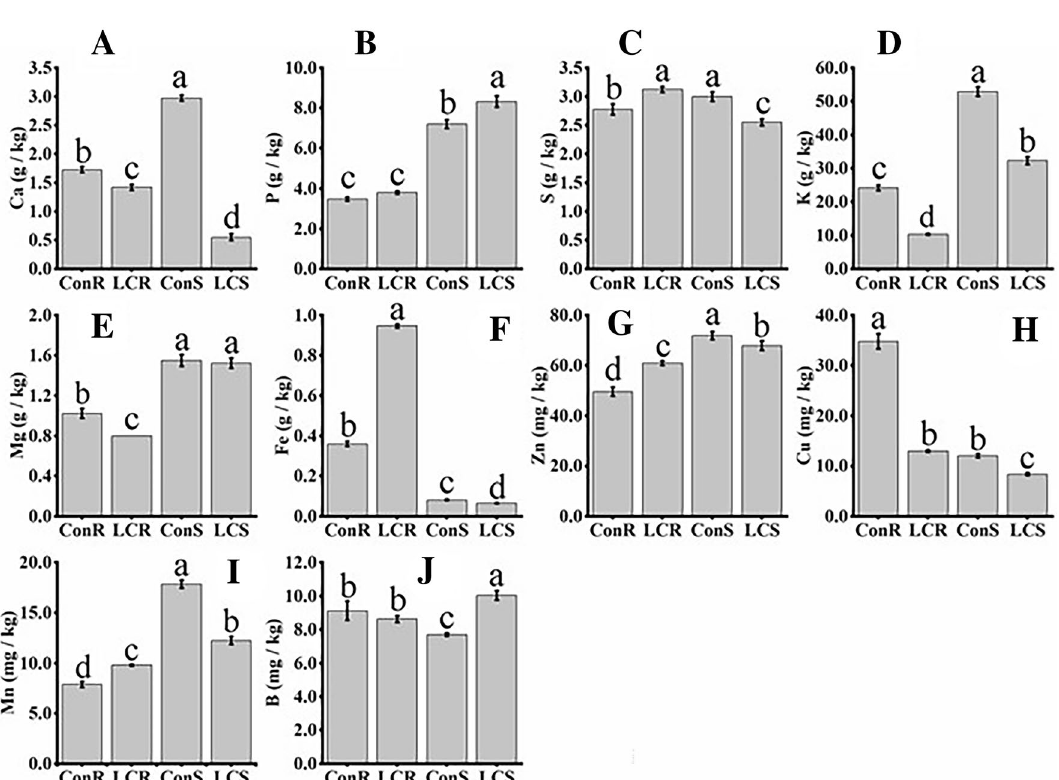
Figure 2. Mineral content profiling of tef plants grown under low or optimum Ca conditions. Shoot and root Ca ( A ), P ( B ), S ( C ), K ( D ), Mg ( E ), Fe ( F ), Zn ( G ), Cu ( H ), Mn ( I ) and B ( J ) were analyzed using ICP-OES as described in the “Materials and methods” section. Bars represent mean and SD of at least 4 independent biological replicates, and different letters indicate statistically significant difference ( p <